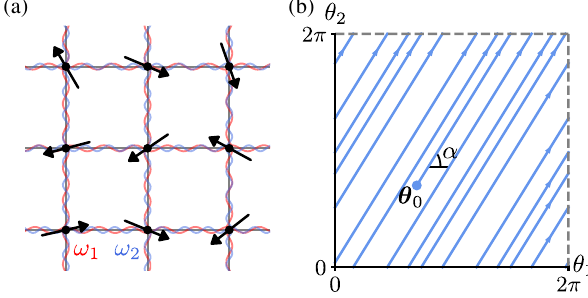
FIG. 1. (a) Cartoon of an ensemble of spins that is quasiperiodi- cally driven. (b) A time-quasiperiodic Hamiltonian H ð t Þ arises from evaluating a Hamiltonian H ð θ Þ defined on the m -dimen- sional torus T m ∋ θ on the trajectory θ ð t Þ ¼ ω t þ θ 0 (blue arrows). As the frequency vector ω is a set of rationally independent frequencies, the trajectory never returns to itself but covers the torus uniformly. Shown here is the case m ¼ 2 , with tan α ¼ ω 2 = ω 1